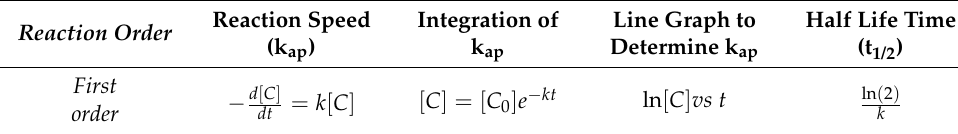
Table 4. Kinetic parameters for rhodamine B degradation reaction.